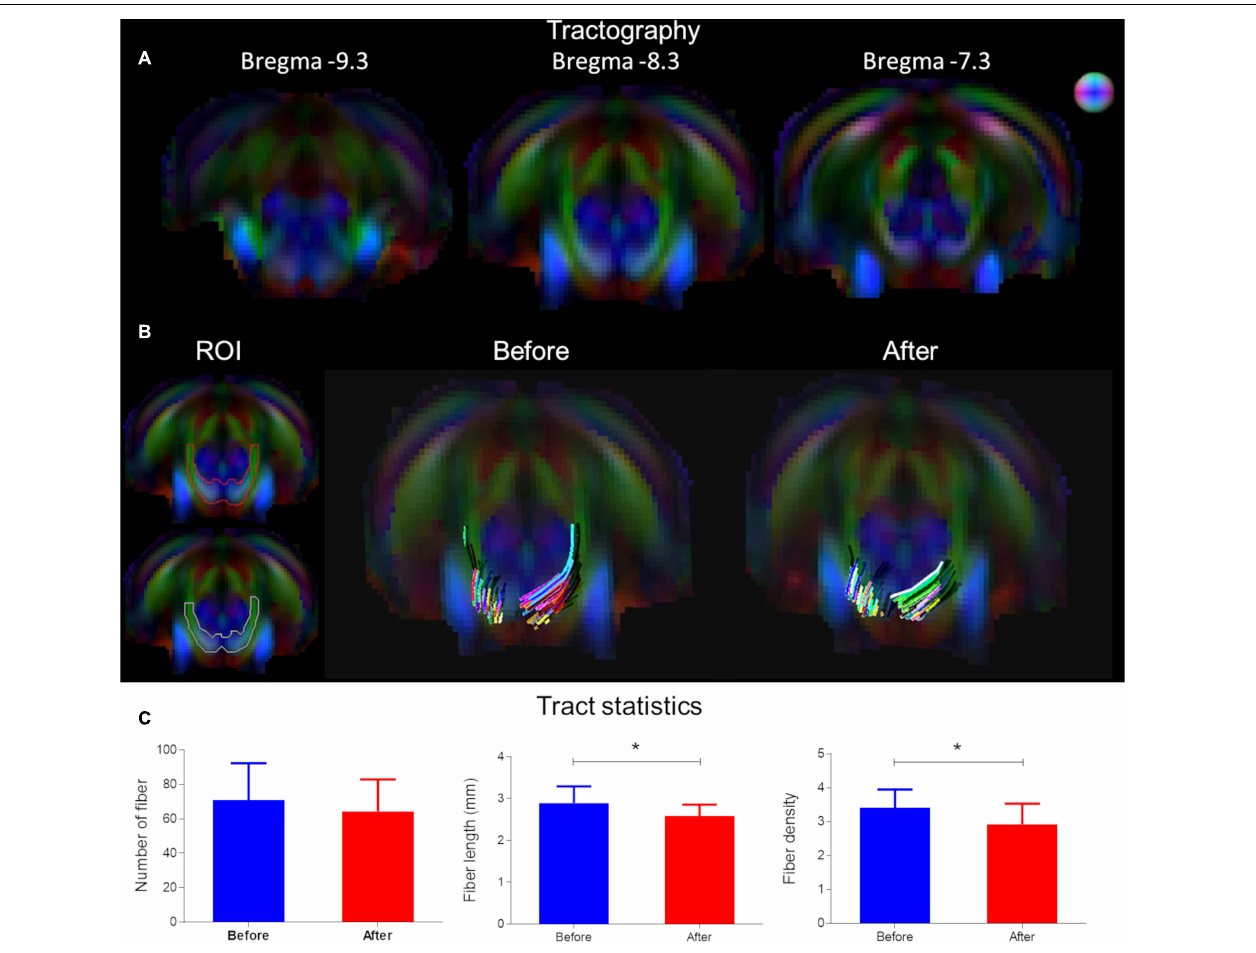
FIGURE 4 | Tract alterations underlying conductive hearing loss assessed by tractography. (A) Tractography was used to delineate the ventral aspect of lateral lemniscus on Bregma –7.5, –8.6, and –9.7 mm. The color map shows the primary eigenvector in the region of the ventral lateral lemniscus traversing upward in the ventral-dorsal direction. (B) The tractography panel ROI demonstrates the fibers originate from a ventral position and course upward dorsally in a bilaterally symmetrical fashion. (C) Bar plots of tract metrics in the ROI for the lateral lemniscus. The mean fiber number was insignificantly different after CHL; however, the mean fiber length and mean fiber density for the lateral lemniscus after CHL was significantly decreased compared to before ( t -test: t = 2.548, df = 30, p = 0.0162 and t = 2.388, df = 30, and p = 0.0234,